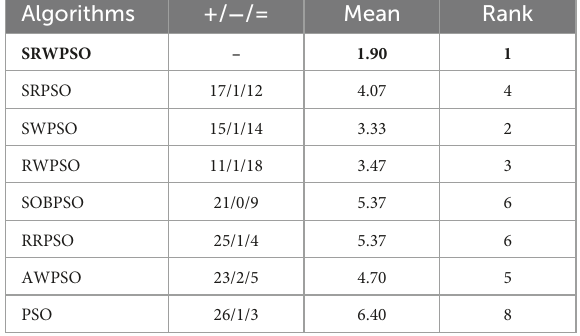
TABLE 6 The results of Wilcoxon signed-rank test of different